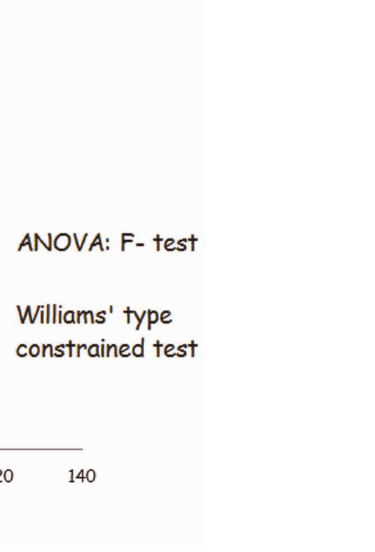
Figure 1. Results of a simulation study to compare power and sample sizes of F-test in One-way ANOVA with the constrained inference Williams’ type test where the critical values are derived using 10,000 bootstrap samples. The power of the Williams test was estimated by averaging 1000 simulated where the critical values are estimated using 10,000 bootstrap samples. The power for F-test was determined using PROC POWER in SAS (9.0). The null hypothesis was that the means of the four dose groups were equal (and zero) and the alternative hypothesis was that the means of the four dose groups have an increasing trend with dose. Data representing the four dose groups were simulated from normal populations with dose means taken to be 0, 0.1, 0.5 and 1, respectively. The actual values of the doses are irrelevant for the two methods described here. The population standard deviation for the four populations was taken to be 1. Corresponding to the 14 different patterns of total sample sizes, namely, 20, 24, 28, 32, 36, 40, 44, 48, 52, 60, 76, 80, 100, 116, the powers of the two methods are plotted. The Type I error was set to 0.05.